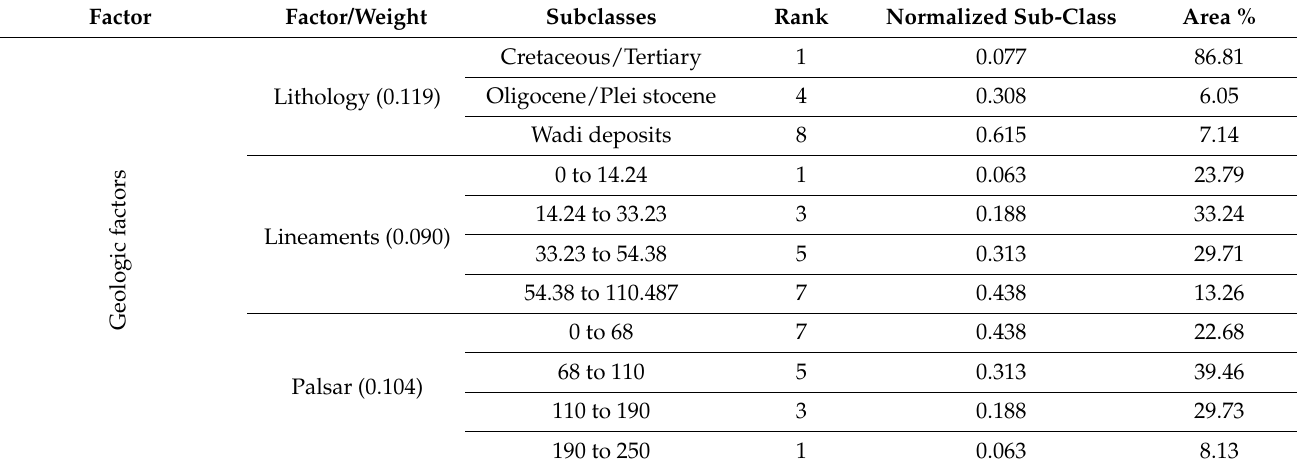
Table 4. Map of weighted prospective groundwater